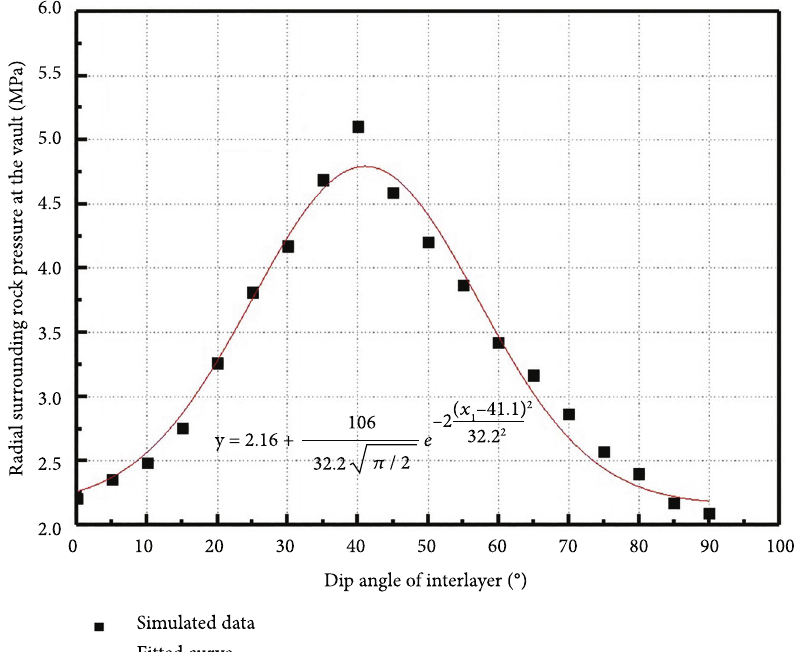
Figure 6: Fitting curve of the relationship between the surrounding rock pressure of the vault and the weak interlayer with di ff erent dip